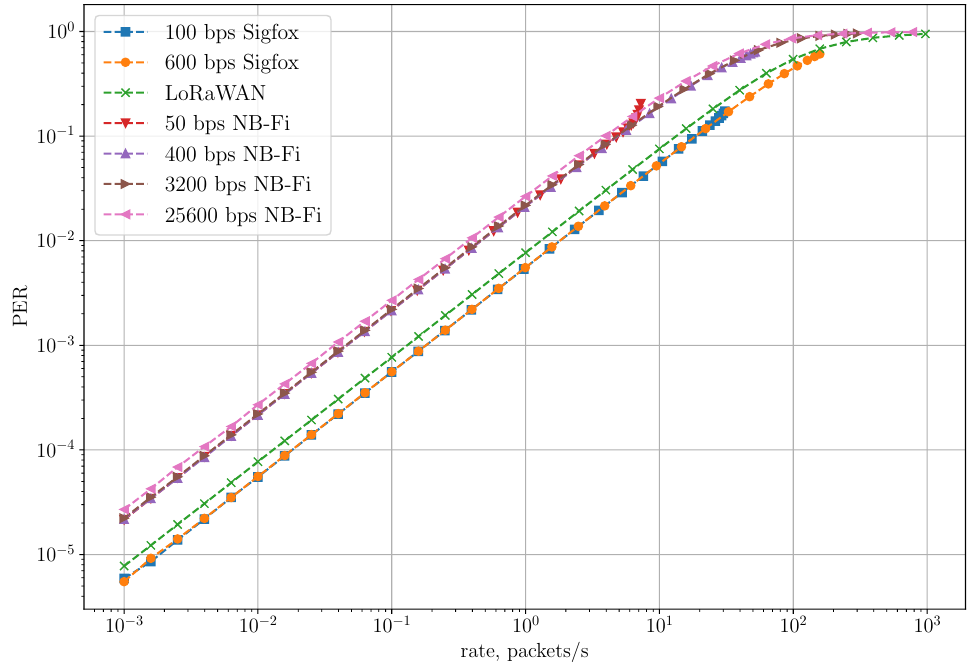
Figure 12. PER for the unreliable transmission of long packets